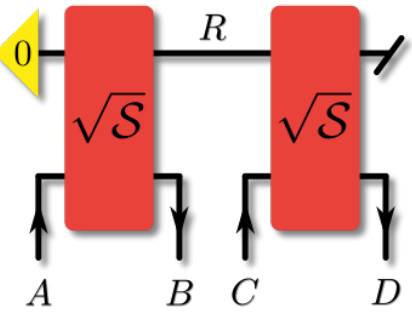
Figure 15: 4 -partite genuinely multipartite entangled comb. See text for